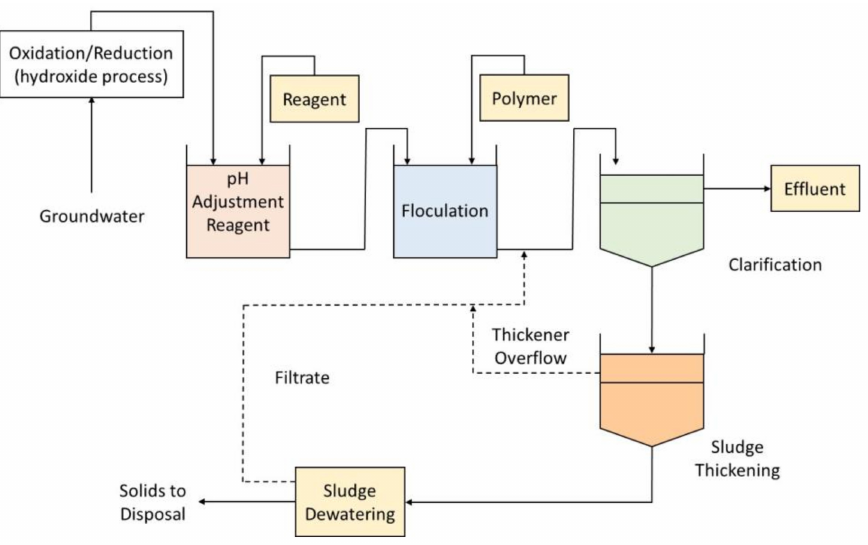
Figure 2. The general process involved in chemical precipitation